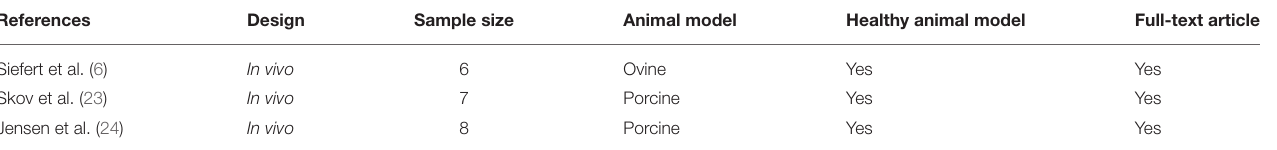
TABLE 1 | Characteristics of included